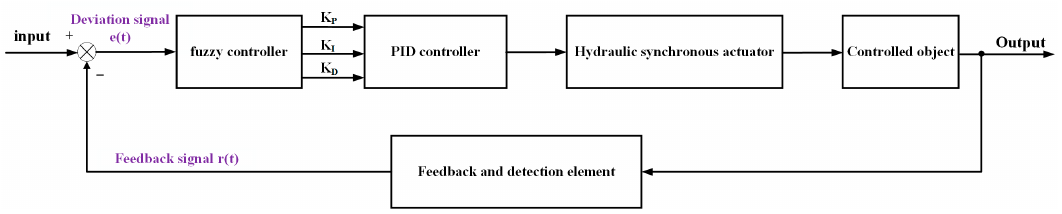
Figure 11. Fuzzy PID control block diagram of hydraulic synchronization control system.